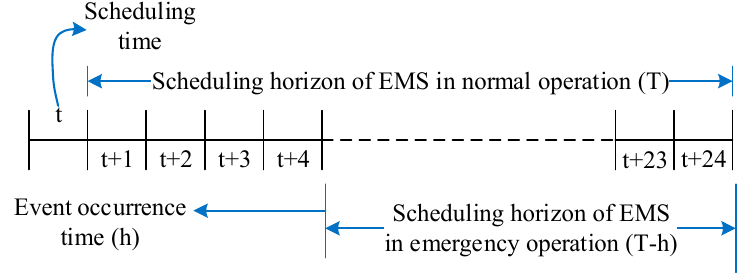
Figure 6. Scheduling horizons of different operation modes of the proposed microgrid.